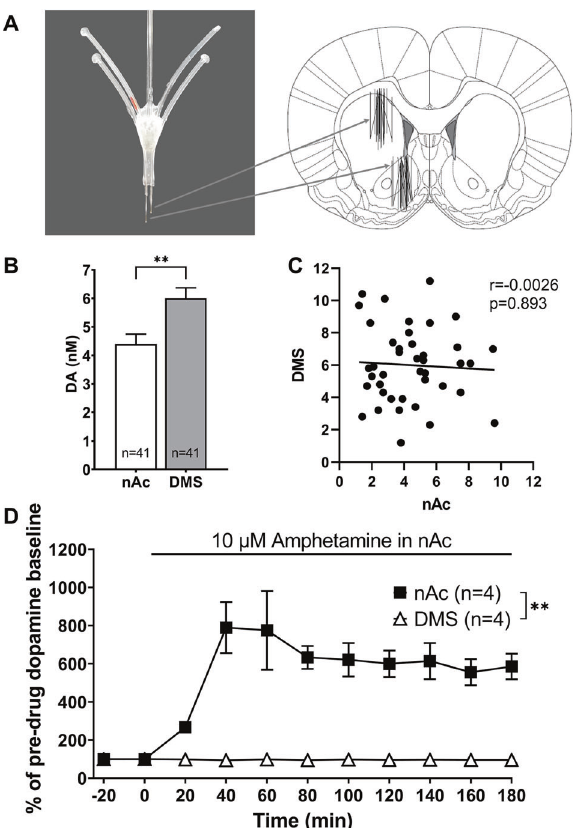
Fig. 1 Higher dopamine dopamine levels in the DMS during basal conditions. A Photograph of the custom-made dual microdialysis probe used, with a schematic illustration of the probe placement in the DMS and the nAc. B Basal extracellular levels of DA in the DMS and nAc. C Correlation analysis of DA in the nAc and DMS, with no apparent correlation between basal levels of DA in the two regions. D Local administration of 10 µM amphetamine in the nAc elicits a substantial DA release in the nAc only. All values are presented as means ± SEM. n number of rats. ** p <